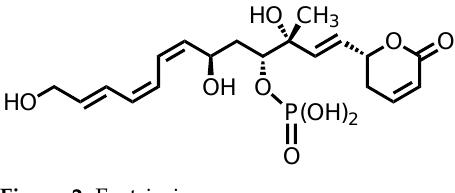
Figure 2. Fostriecin. Figure 2.